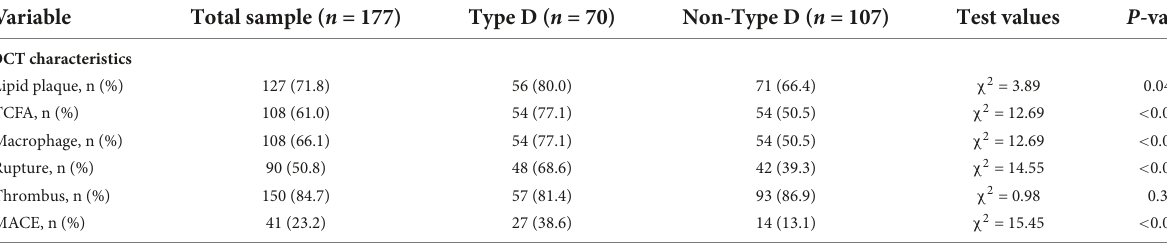
TABLE 2 OCT analysis and MACE in Type D and non–Type D patients.